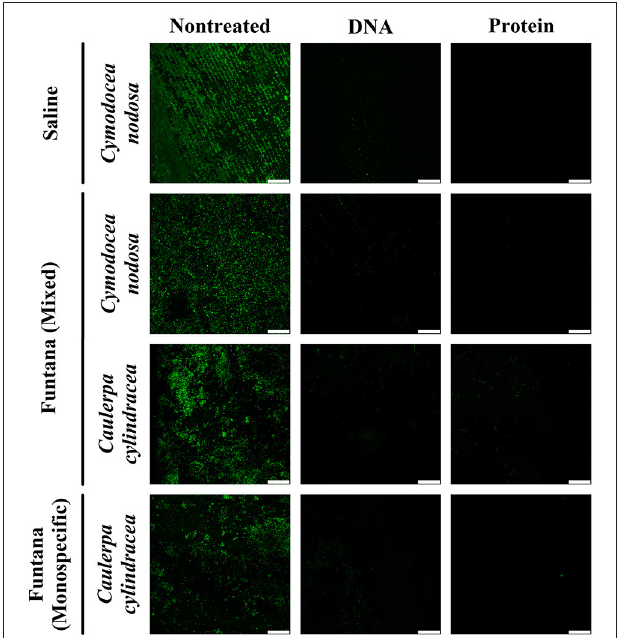
FIGURE 1 | Confocal microscope images of C. nodosa and C. cylindracea surfaces from the Bay of Saline and the Bay of Funtana (mixed and monospecific settlements) sampled on December 4, 2017 and stained with SYBR Green I. Scale bar at all images is 60 µ m.